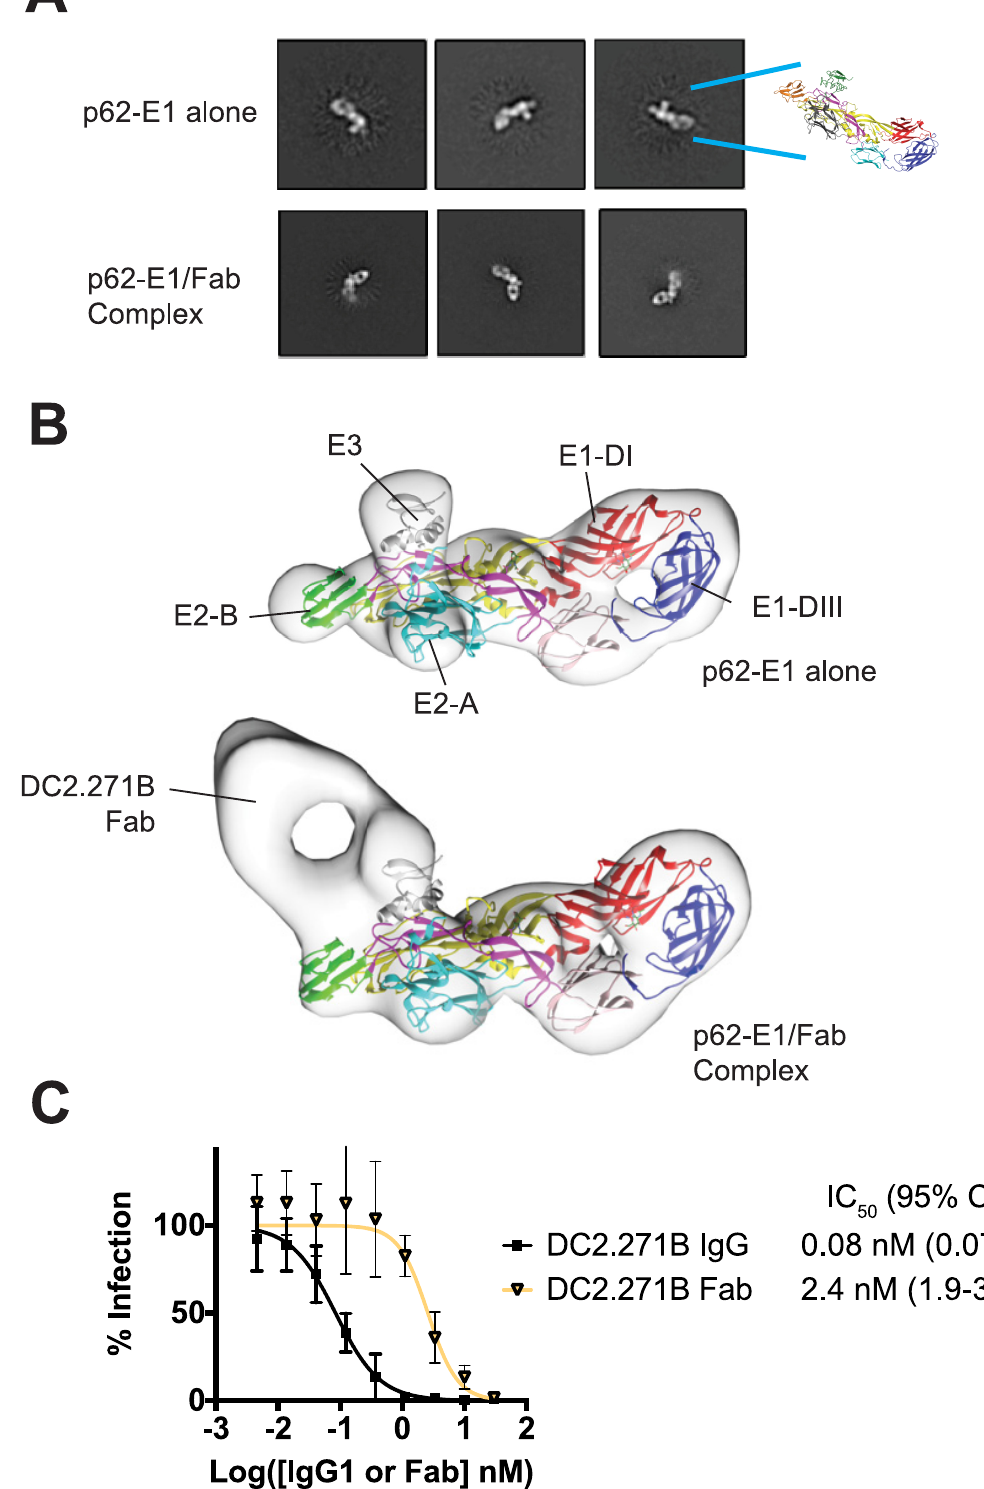
Fig 7. Recognition requirements for DC2.271B. CryoEM visualization ( A) and single particle three-dimensional reconstruction ( B ) of p62-E1 alone and in complex with DC2.271B Fab. ( C ) Neutralization of CHIKV 181/25 by DC2.271B IgG1 and Fab. Data are pooled from two experiments each performed in triplicate (points represent mean ±